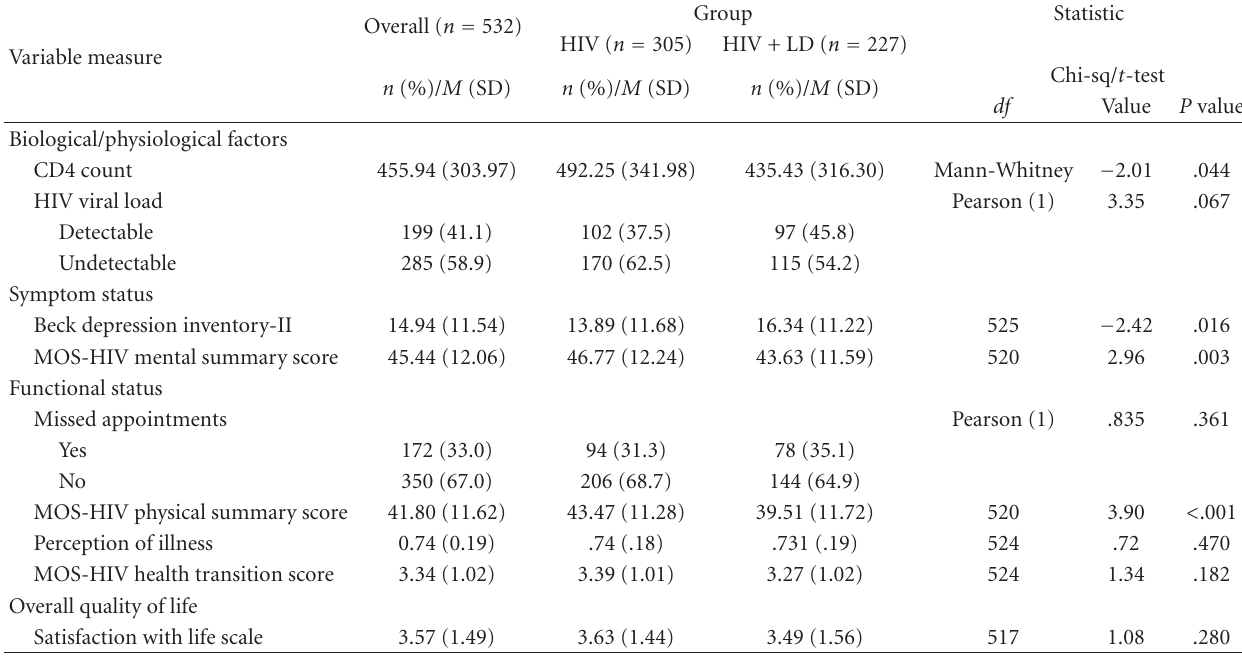
Table 2: Measure comparisons by model variable for HIV and HIV + LD